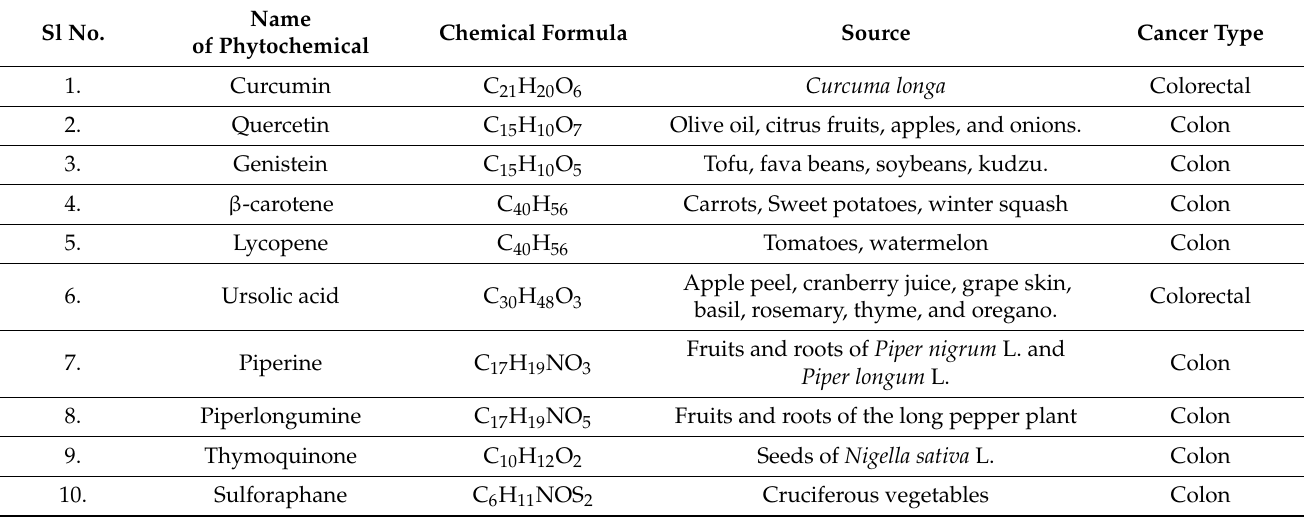
Table 1. Table representing some of the phytochemicals used for preclinical analysis for CRC [31]. Sl No.